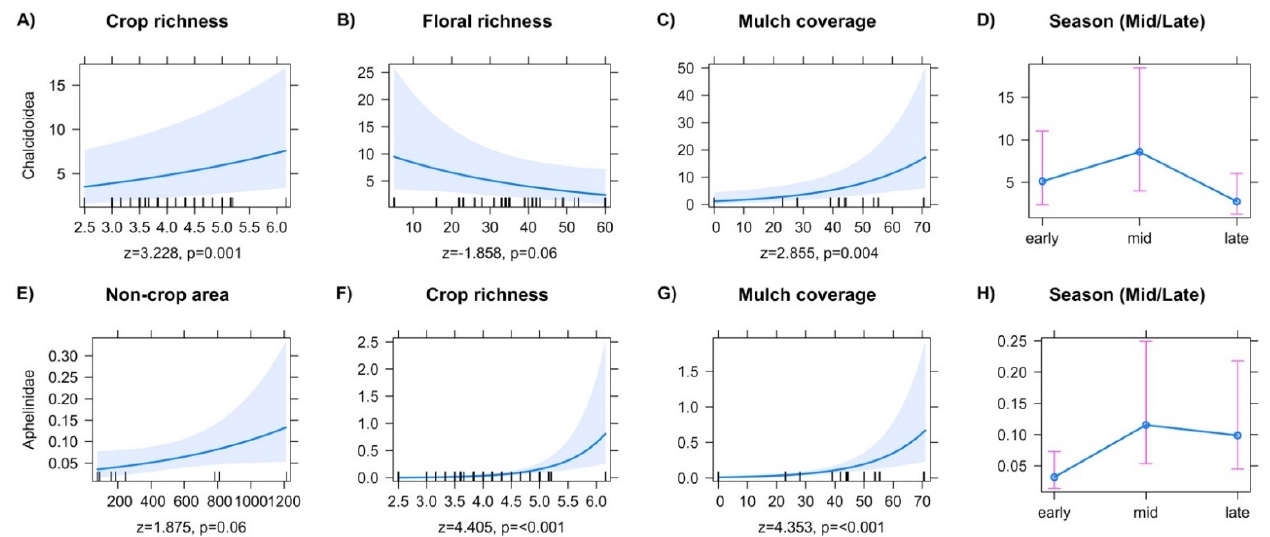
Figure 2. Predictor effect plots for individual explanatory variables on the abundance of superfamily Chalcidoidea ( A – D ), and family Aphelinidae ( E – H ).